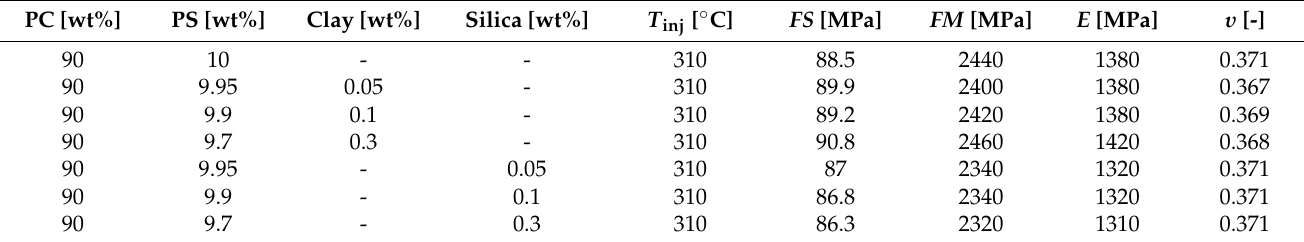
Table 5. Elastic properties of PC/PS/clay and PC/PS/silica